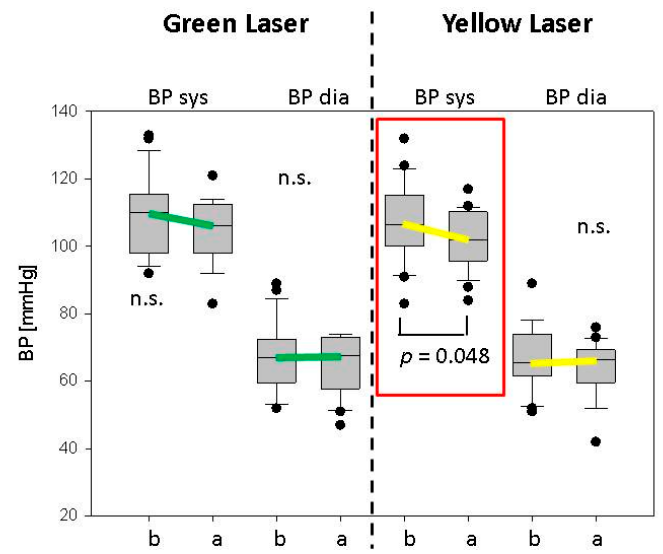
Figure 6. Blood pressure results of the 22 subjects before and after green or yellow laser stimulation. Note the significant decrease in systolic values (BP sys) after yellow laser stimulation at the ear point Shenmen (red rectangle).